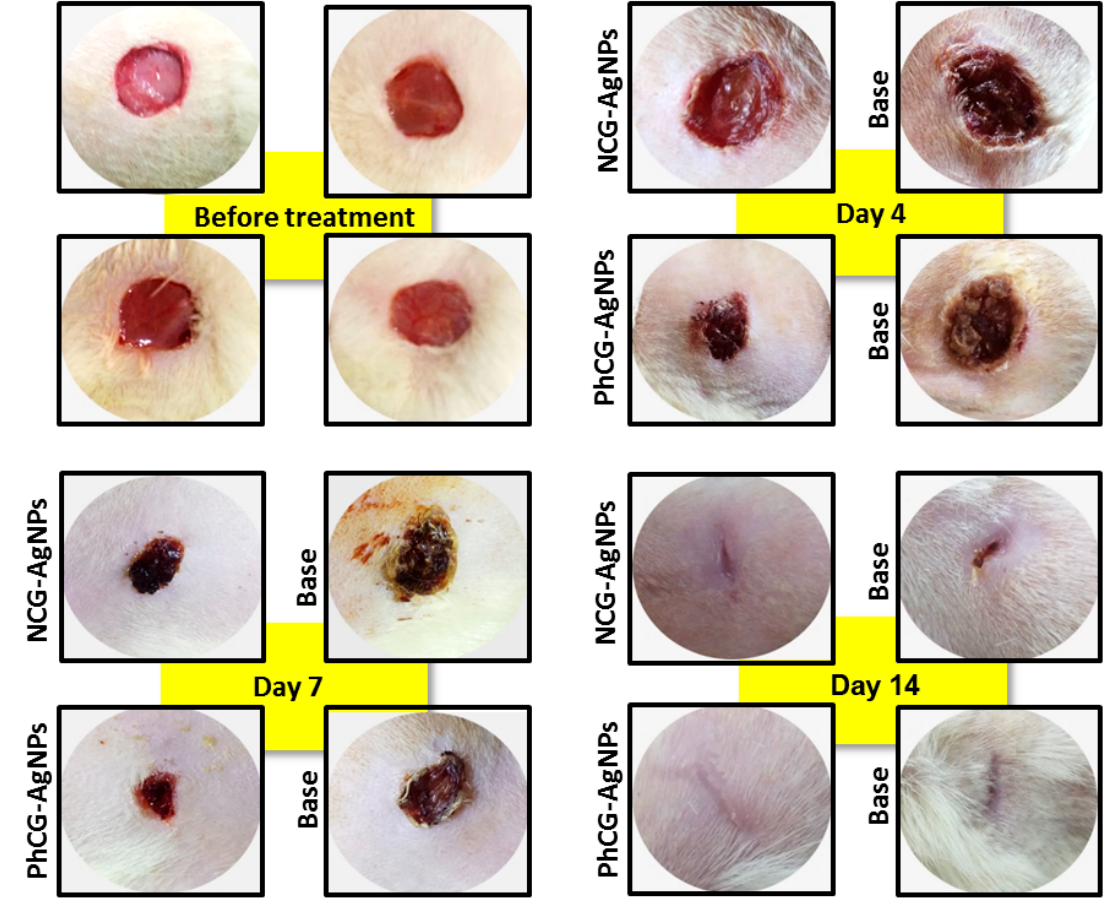
Figure 8. Representative images of the healing process caused by AgNPs-hydrogels on the back of rats models.